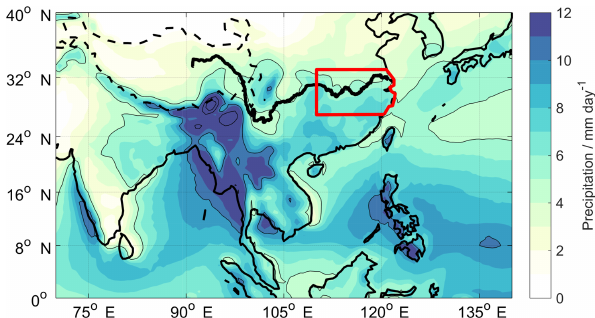
Figure 1. ERA-Interim precipitation (shading) over South and East Asia in millimeters per day (mmd − 1 ). Black contours are shown every 5mmd − 1 . The YRV target region (red), the Yangtze River (black), and the 4km topography contour of the Tibetan Plateau (dotted line) are shown. Precipitation is the 1980–2016, April– September